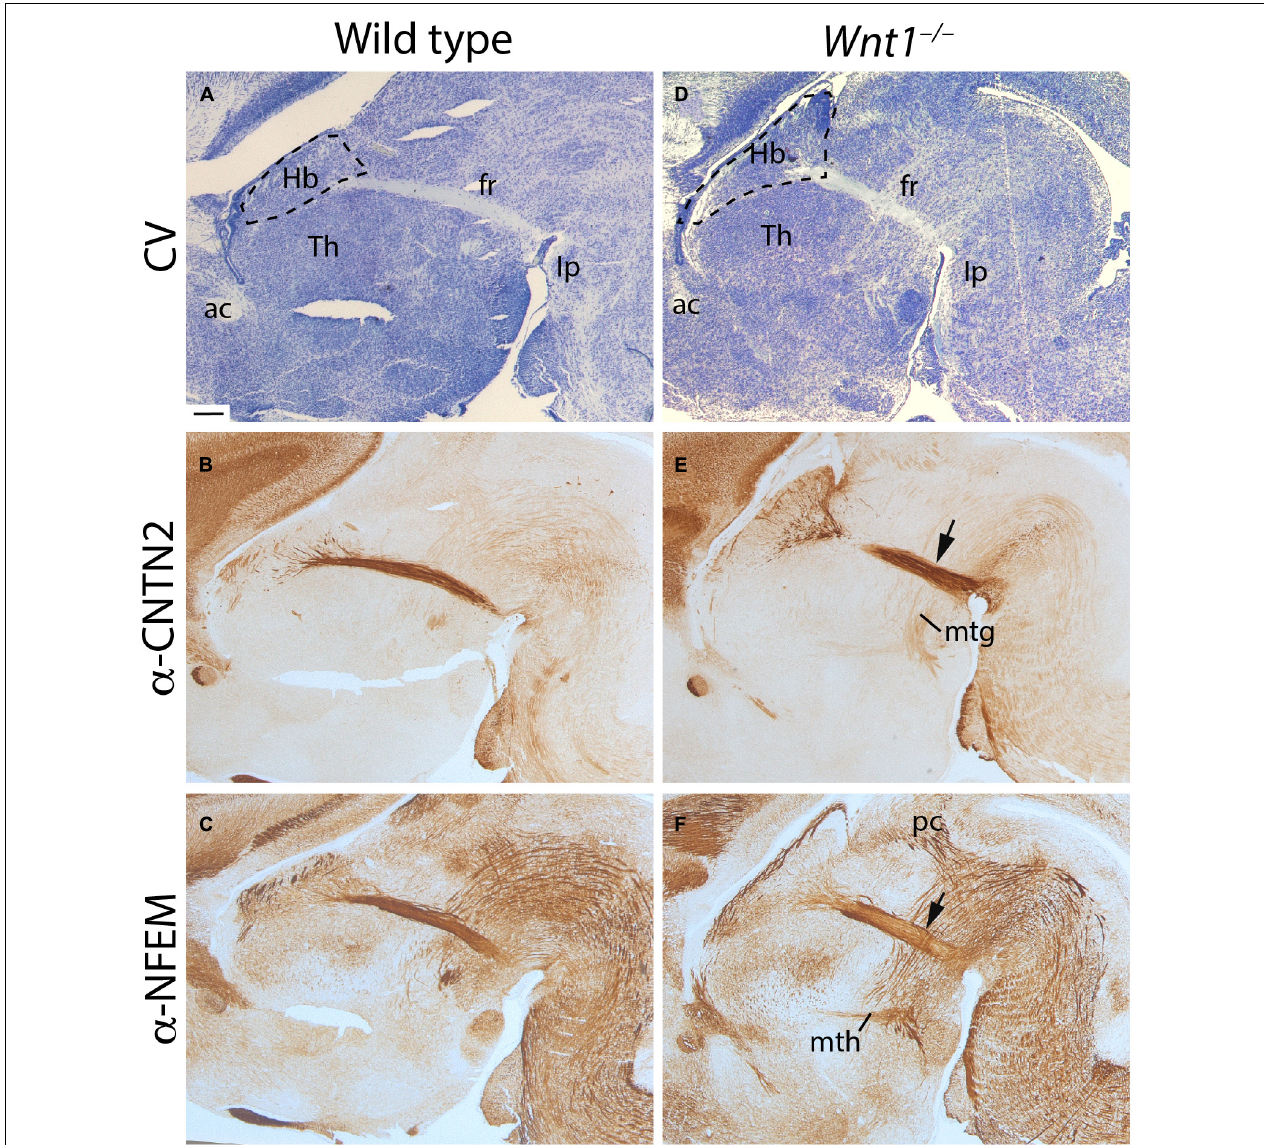
FIGURE 1 | Wnt1 − / − habenular general phenotype. E18.5 wt (A–C) and E18.5 Wnt1 − / − brain sagittal sections (D–F) . (A,D) Are stained with cresyl violet, (B,E) are labeled for CNTN2 (as mHb marker), and (C,F) for NFEM (as lHb marker). The tract was thicker (arrows in E,F ), and the Hb was larger in the mutant embryo. Five samples of each genotype have been analyzed. fr, fasciculus retroflexus; Hb, habenula; mtg, mamillotegmental tract; mth, mamillothalamic tract; Th, thalamus; ac, anterior commissure; Ip, interpeduncular nucleus; pc, posterior commissure; CV, cresyl violet. Scale bar: 200 µ